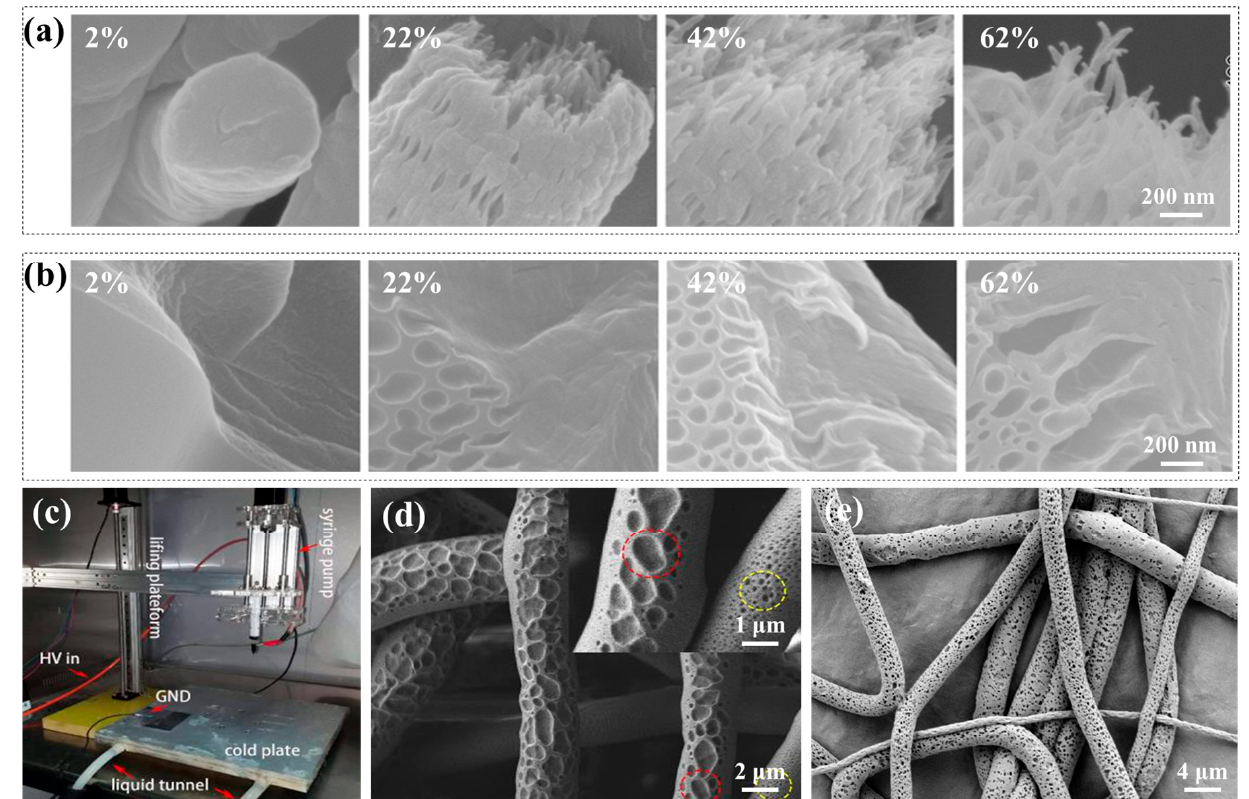
Figure 3. ( a , b ) SEM micrographs of 20 wt.% PS solution in DMF and THF under various relative humidities, respectively. Reprinted with permission from Ref. [60], Copyright 2013, American Chemical Society. ( c ) Configuration of a low-temperature electrospinning system; ( d ) SEM micrograph of PCL porous nanofibers. Reprinted with permission from Ref. [114], Copyright 2019, Elsevier. ( e ) SEM micrograph of porous PCL nanofibers fabricated in a solvent system of CF/DMSO. Reprinted with permission from Ref. [67], Copyright 2015, Elsevier.